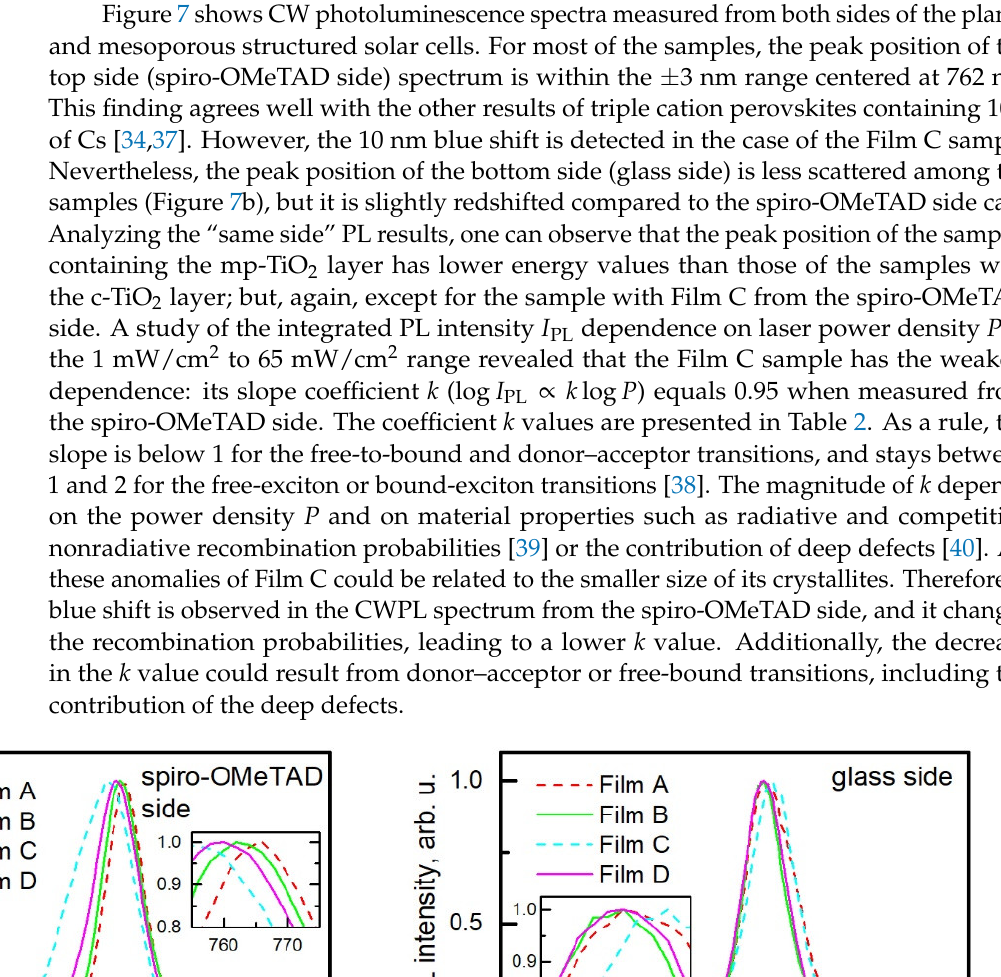
Table 1. The FWHM values of perovskite XRD peaks 100, 110, and 220, crystallite size D, and the value of microdeformation ∆ d/d in different perovskite films.